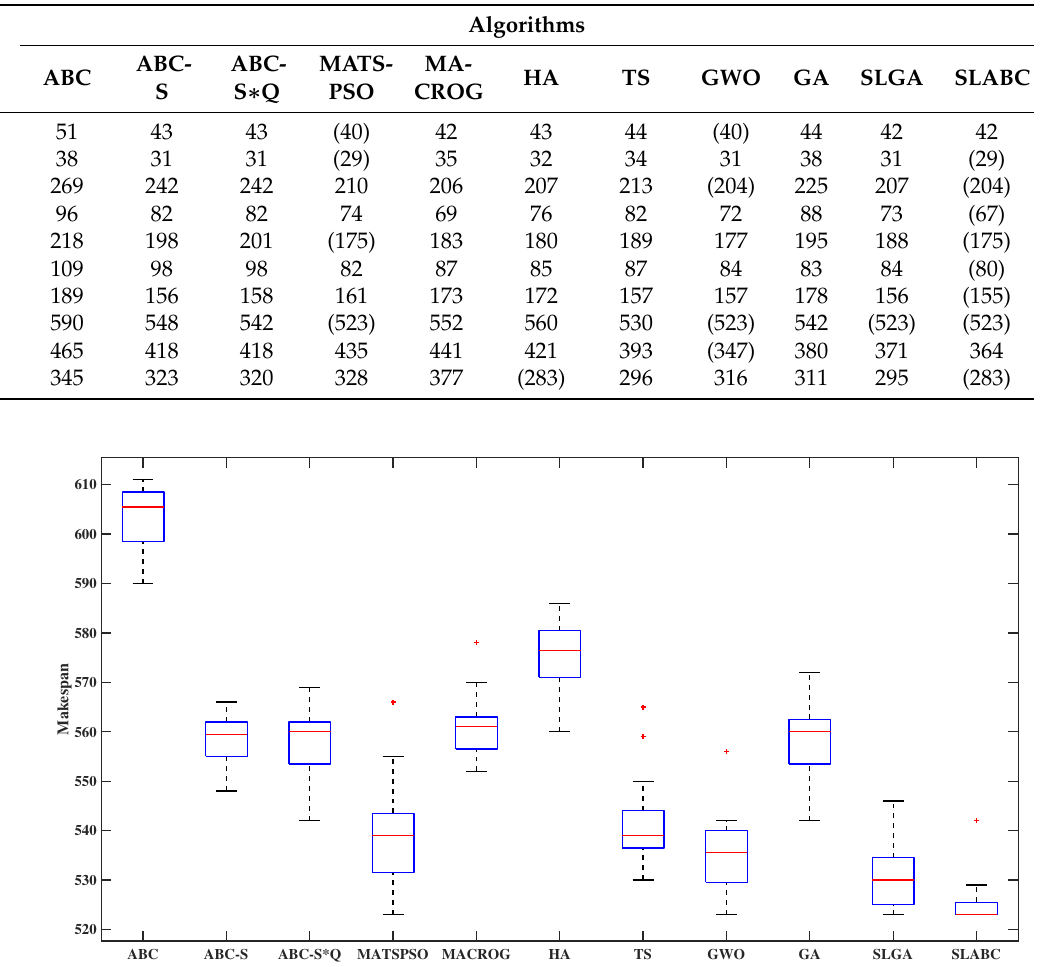
Table 8. The best value (BV) obtained by 11 algorithms to solve 10 Brandimarte instances.